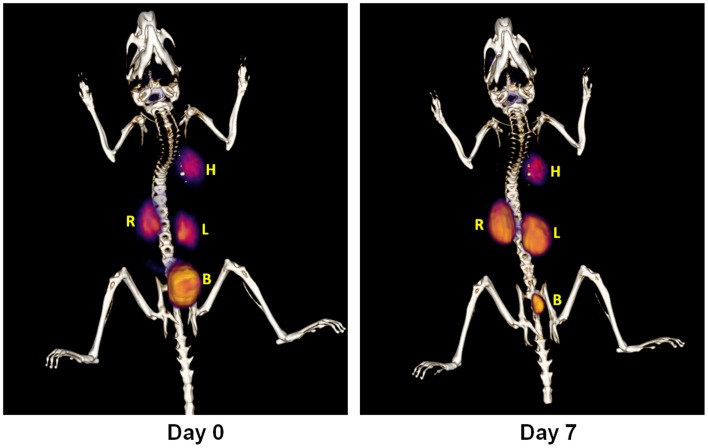
Representative 3D PET-CT images from the dynamic imaging interval of 10–15 min (frame No.3) on days 0 and 7 in anti-GBM nephritis group mice.Left: Day 0 (prior to rabbit IgG injection); Right: Day 7. H - heart, L - left kidney, R - right kidney, B - bladder.